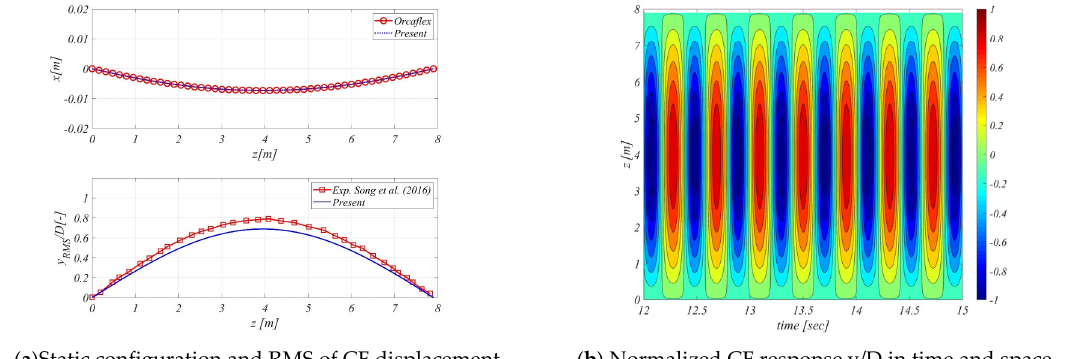
Figure 16. Static configuration and cross flow displacement with uniform current.